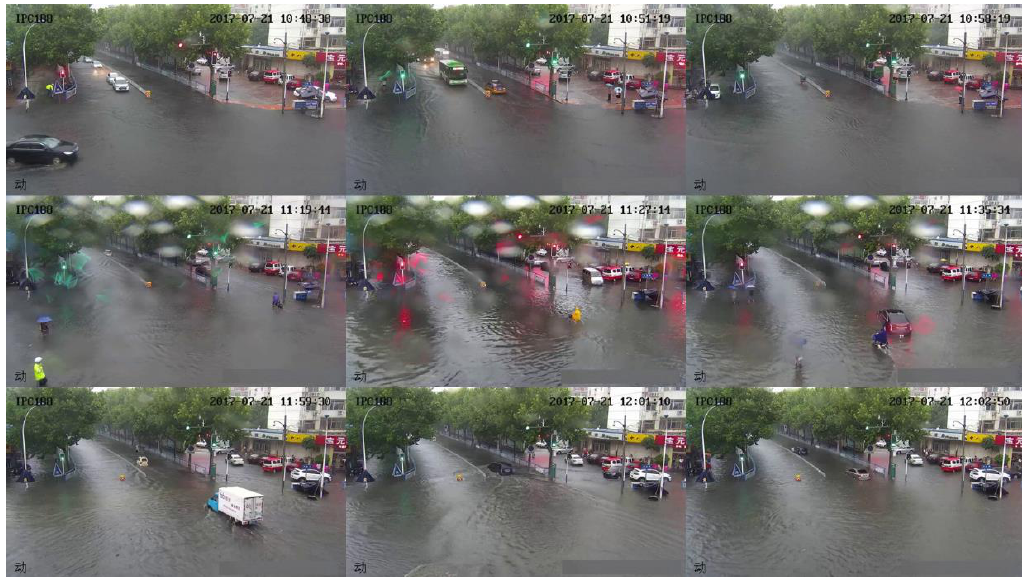
Figure 2. Sample images of video data set 1 in a city in Hebei Province, China.